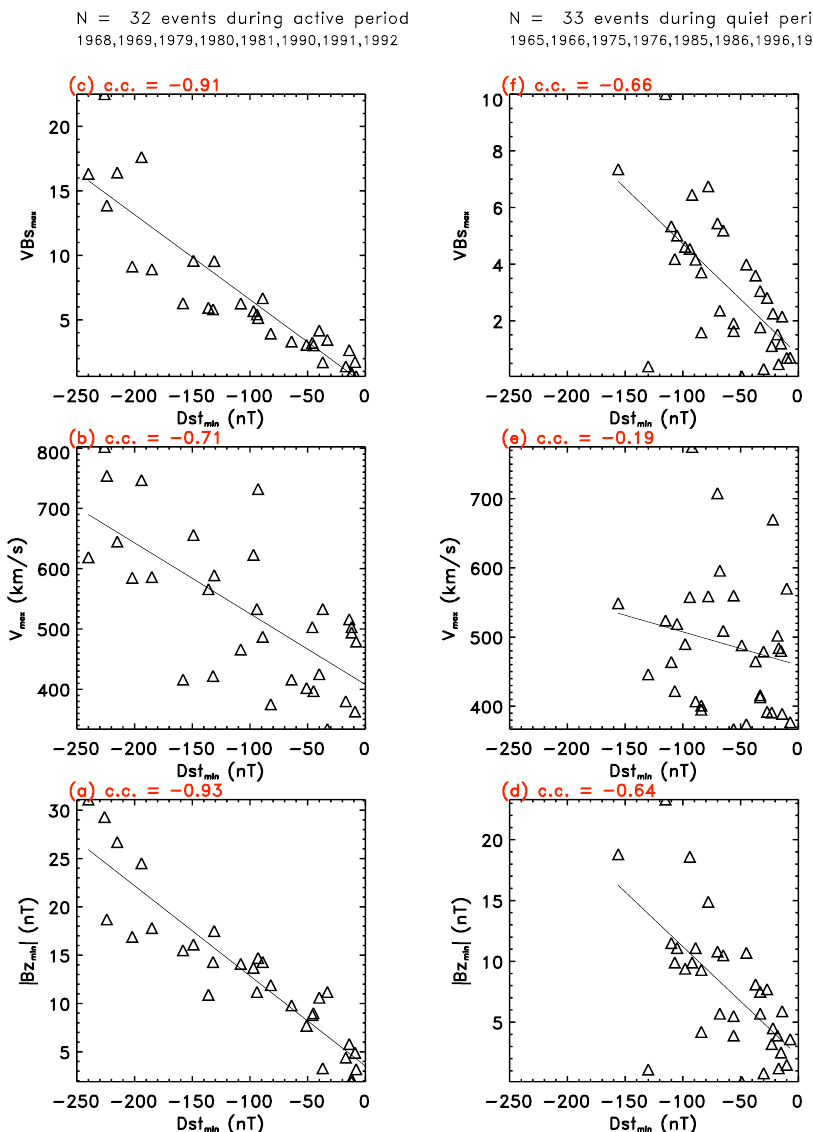
Fig. 3. Relationships and correlation coefficients (c.c.) for storm intensity ( D st ) vs. various solar wind parameters (see the text). The left column represents the results for the 32 events the during solar active period; the right column represents the results for the 33 events during solar quiet